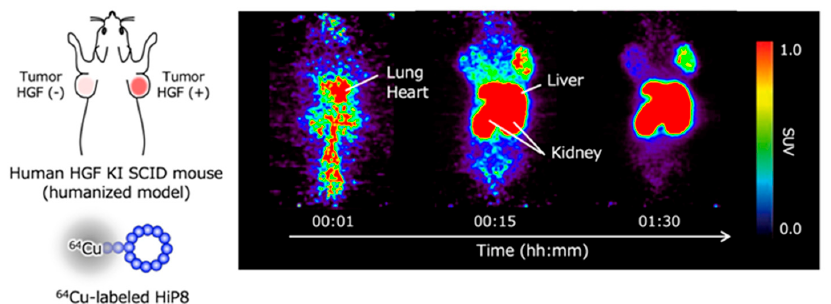
Figure 6. Excellent accumulation of HiP-8 in HGF-high cancer tissues in PET molecular imaging [20].